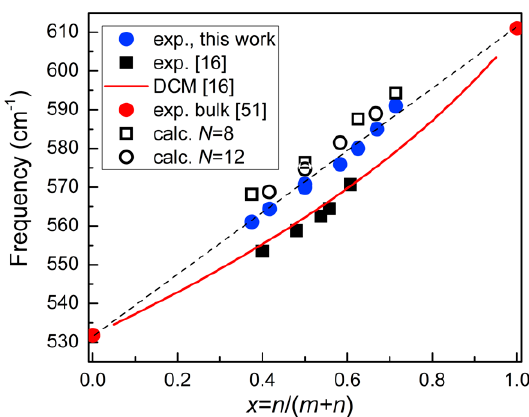
Figure 10. Calculated and experimentally determined frequencies of A 1 (TO) modes in (GaN) m /(AlN) n SLs in dependence of the composition parameter x = n / ( m + n ) . Computational results are shown by open symbols, experimental results by blue circles (this study), and black squares (data from [16]). Red circles indicate A 1 (TO) experimental frequencies in bulk crystals. The ω ( x ) dependence predicted by the dielectric continuum model is shown by the red line.